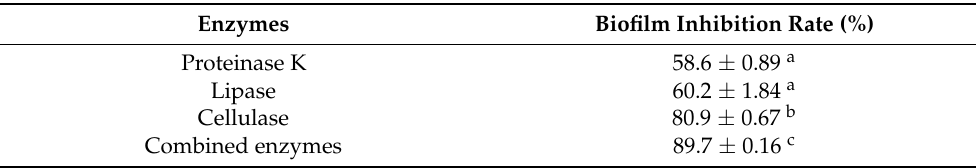
Table 1. Effects of combined enzymes on the biofilm eradication of V. parahaemolyticus incubated in 24-well microplates for 24